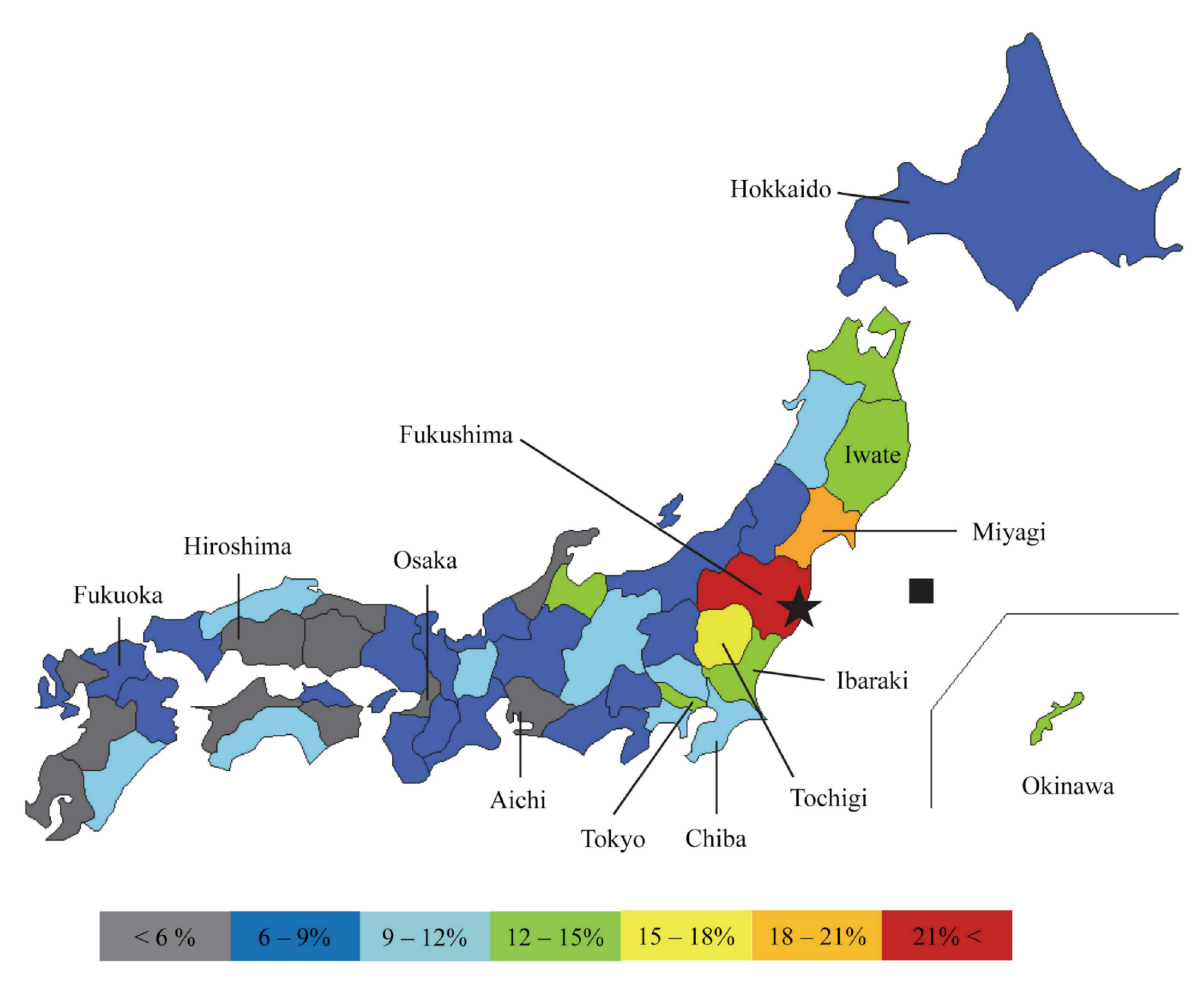
Figure 3. Map of Japan depicting adjusted empirical Bayes estimates for percentage of people with decreased self-perceived health status. Red (>21%), orange (18%–21%), yellow (15%–18%), chartreuse green (12%–15%), aquamarine (9%–12%), blue (6%–9%), and gray (<6%). The black square indicates the epicenter of the earthquake. The black star indicates the location of the Fukushima